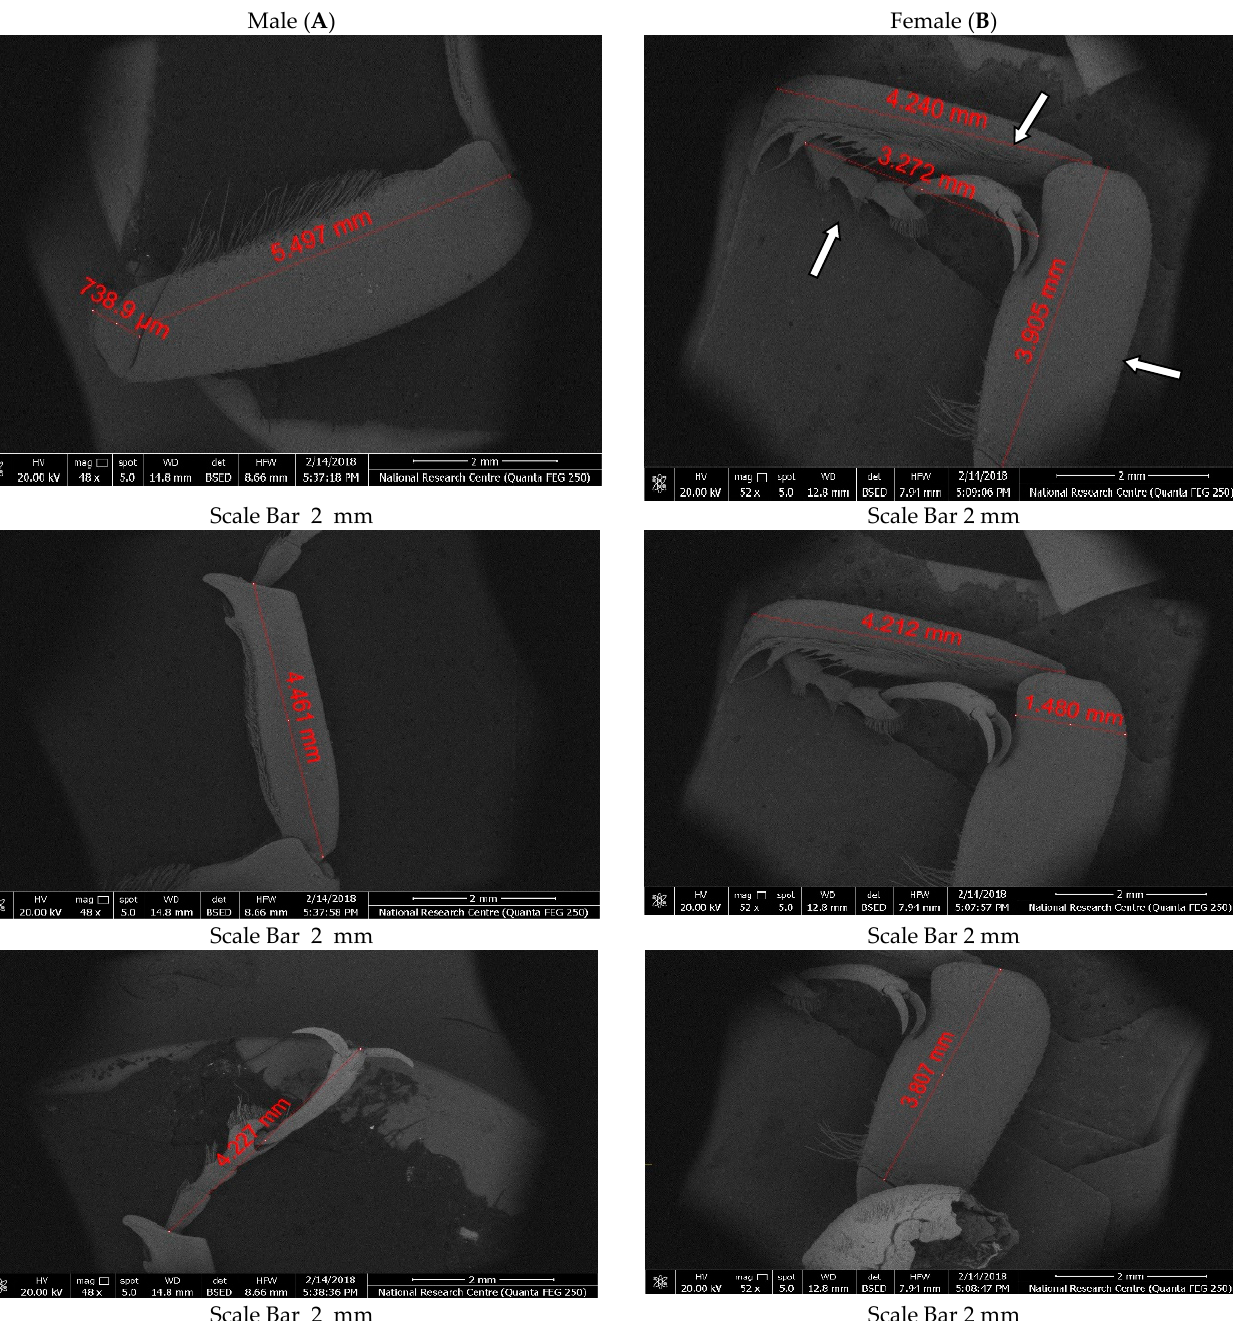
Figure 4. SEM of forelegs of R. ferrugineus adults between RPW male ( A ) and female ( B ) adults, showing the sexual dimorphism between both sexes and high variability (Note: p > 0.05, n = 13 random individuals/sex) (scale bar below each picture and measurements are shown on the picture).